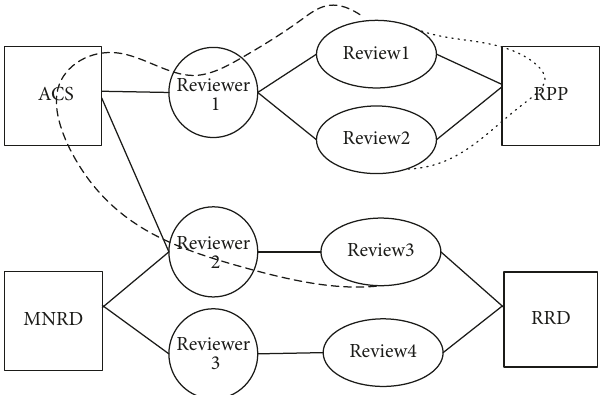
Figure 3: Metapath generation